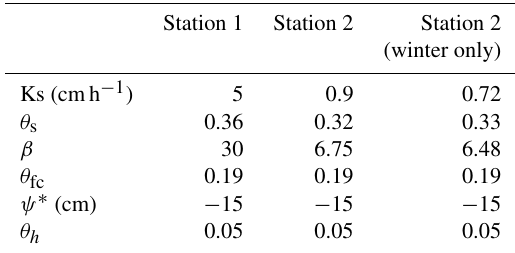
Table 2. Estimated parameters of the hydrological